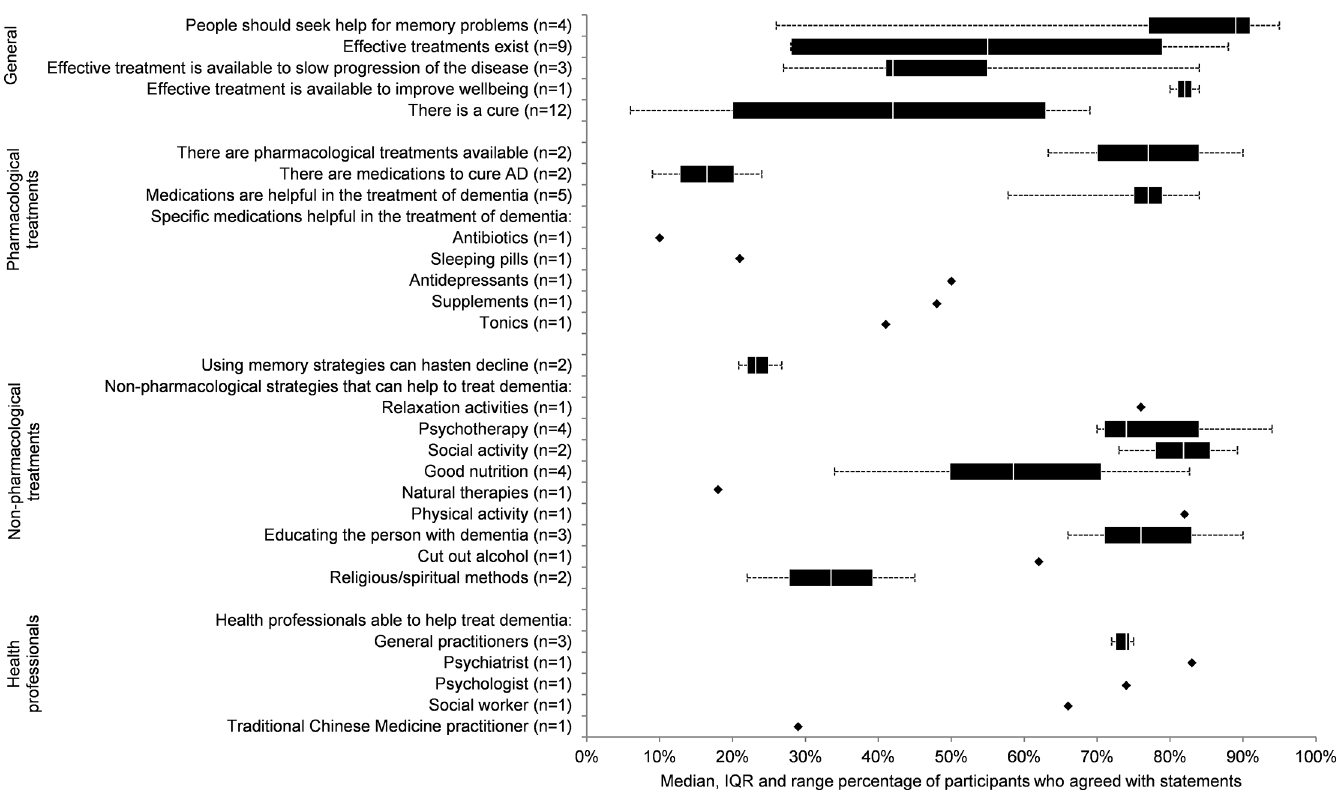
Fig 2. Synthesis of public knowledge and beliefs about treatments for